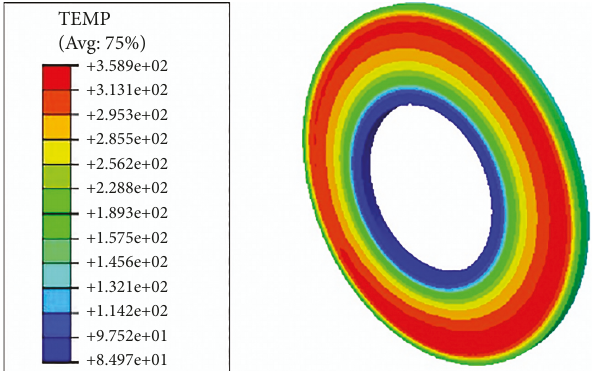
Figure 6: Transient temperature distribution in the disc brake by FEM approach.